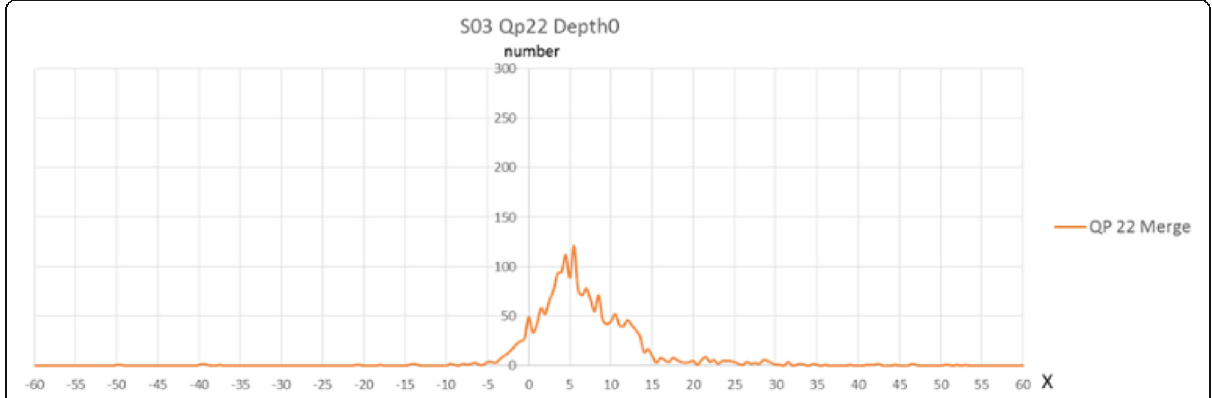
Fig. 8 The distribution of the horizontal component for forward prediction ( V X _ L 0 ) for the S03 sequence